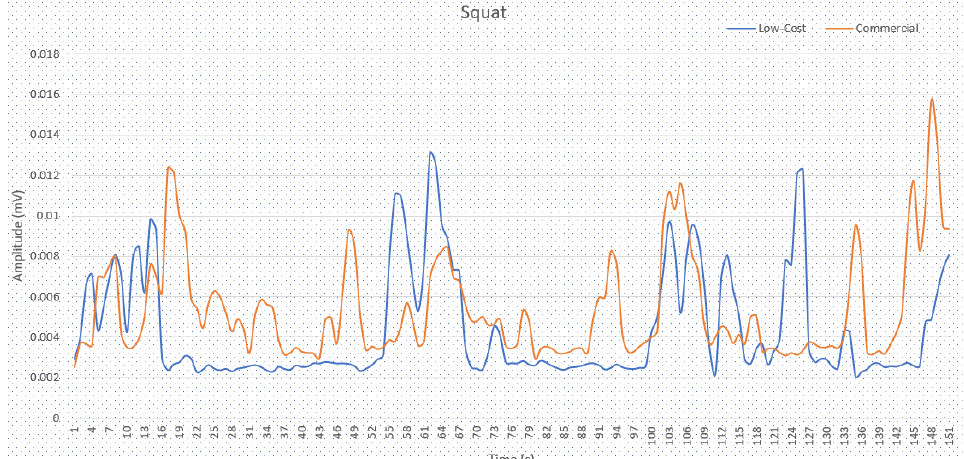
Figure 10. Amplitude graph of